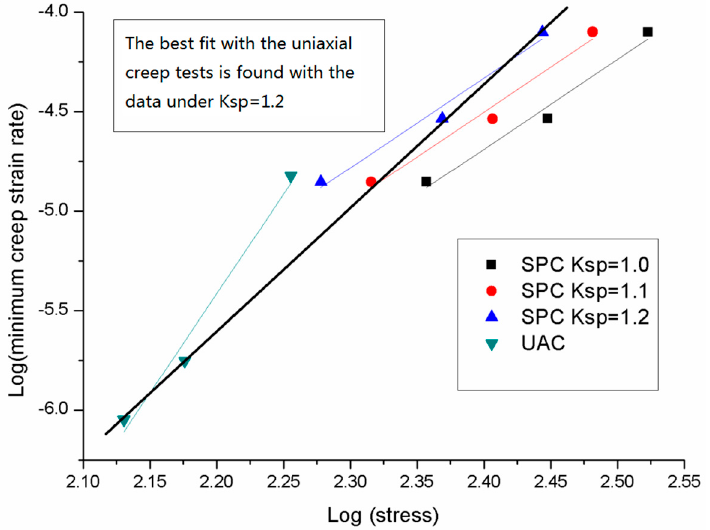
Figure 5. The Norton fitting results of both uniaxial creep results and small punch results of P91.